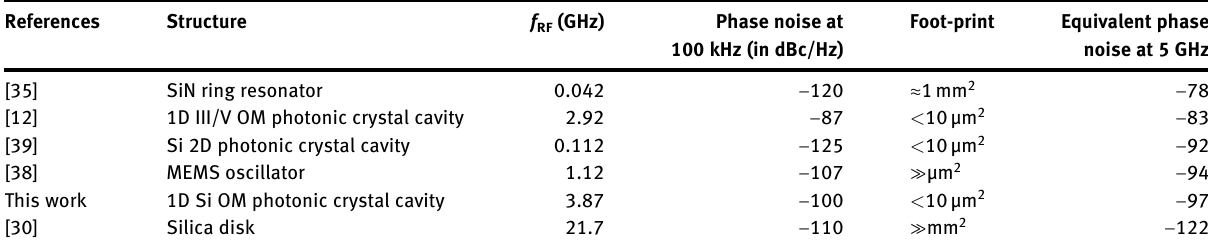
Table  : Comparison of the phase noise of different